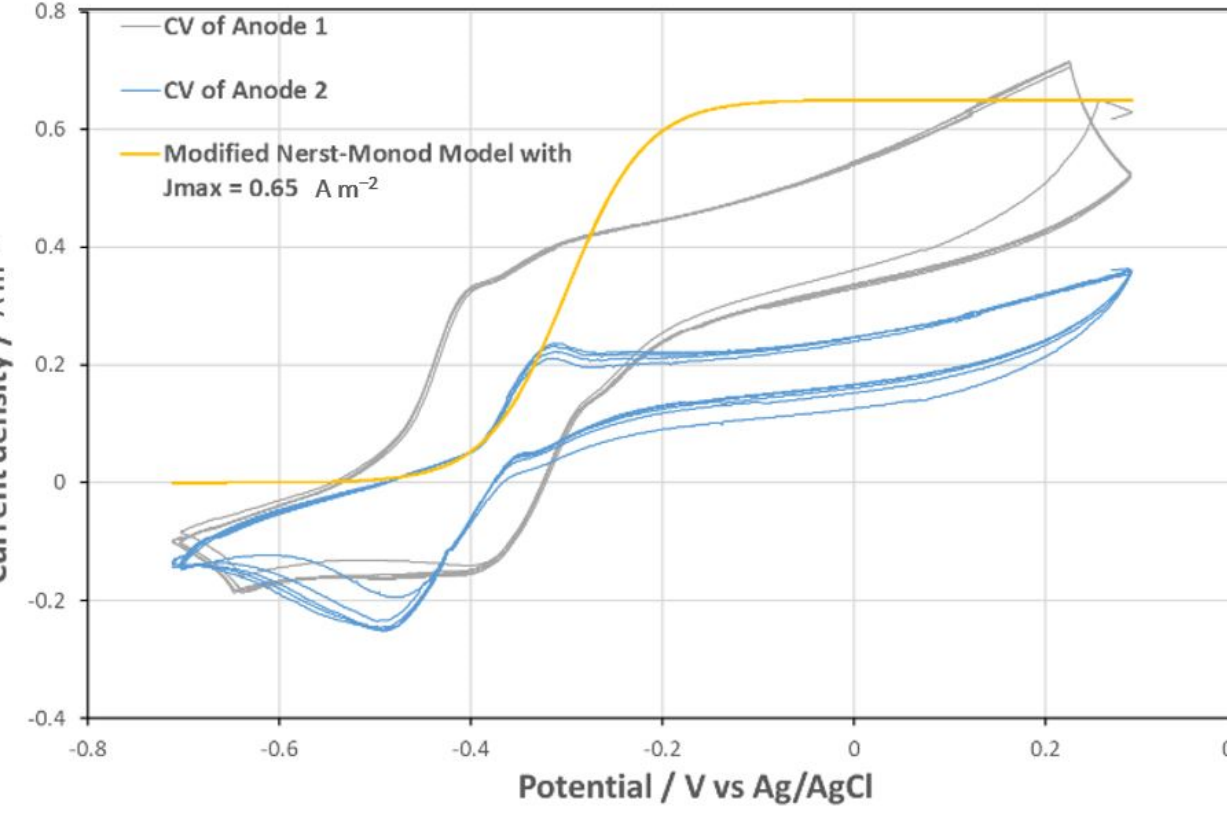
Figure 7. CV of aged anodes on slots 1 and 2, and a modified Nernst-Monod equation curve with J max = 0.65 A m − 2 which was not a validated model of the CVs.